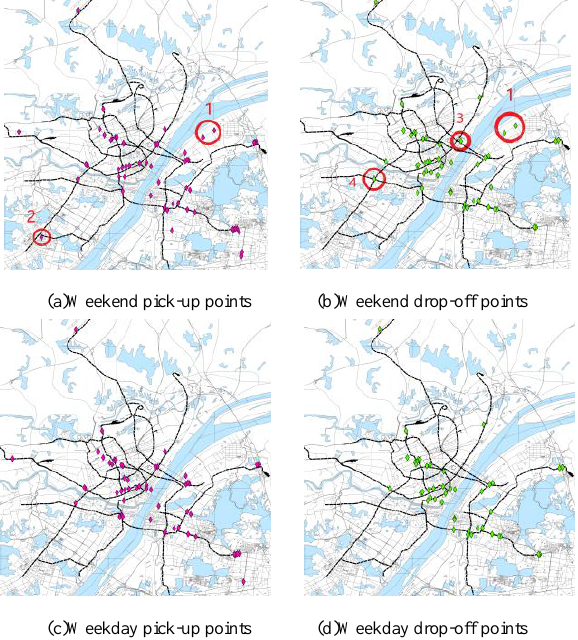
Figure 7. Distribution of level 4-5 docking points on weekdays and weekends